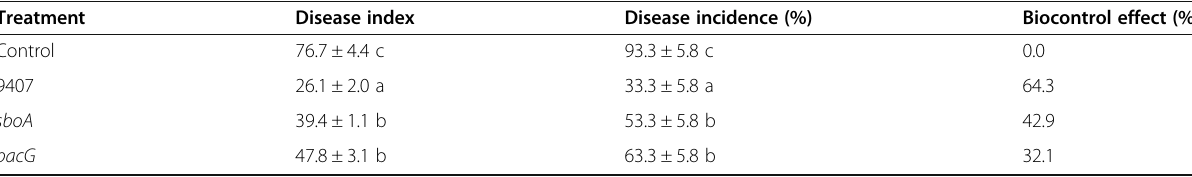
Table 3 Biocontrol efficacy of the sboA and bacG mutants against BFB was decreased under greenhouse conditions